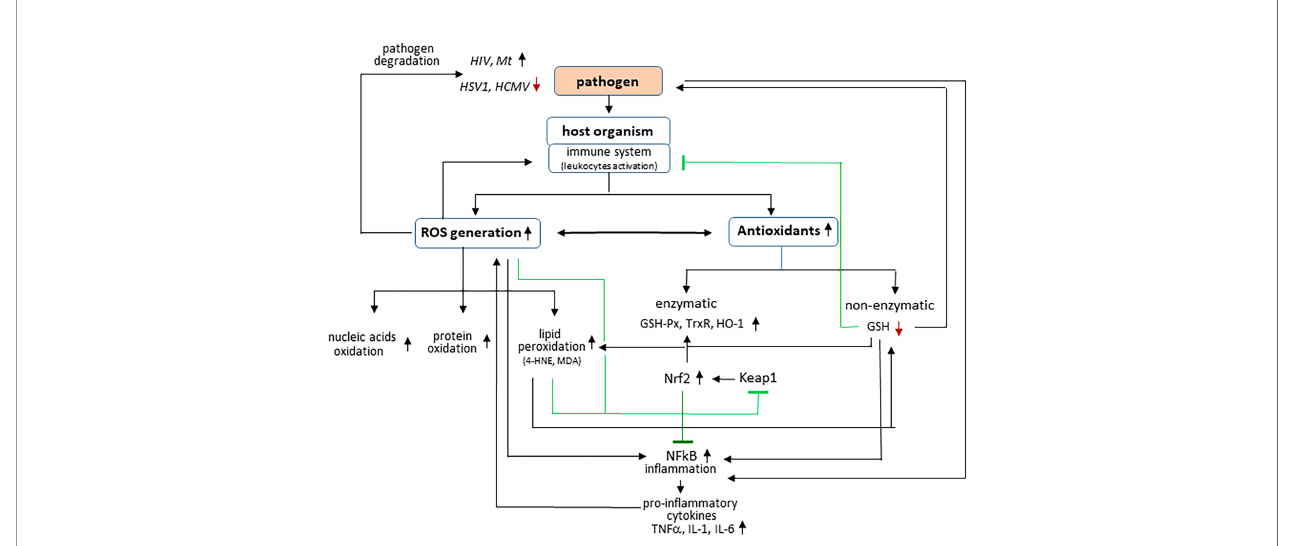
FIGURE 1 | Effect of pathogens on interaction between ROS generation and in fl ammation in host